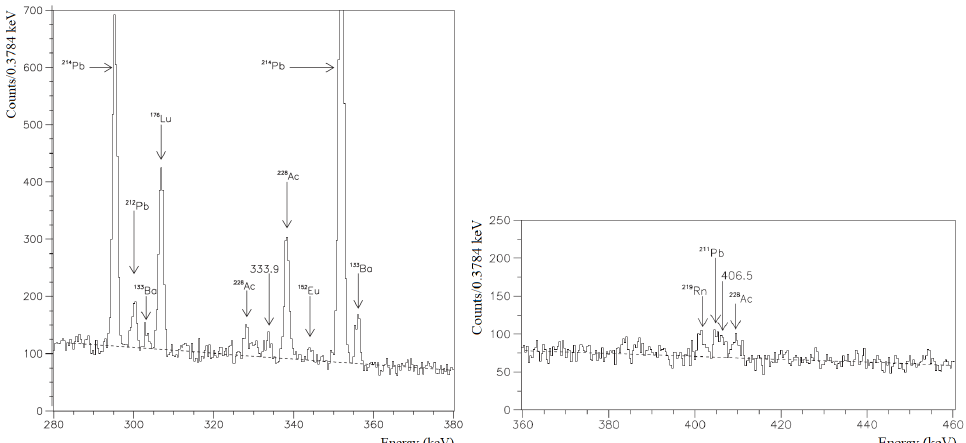
Figure 8. Energy spectrum collected in the HP-Ge experiment of Reference [17]. The two plots show the energy ranges of interest to search for the presence of the gamma’s related to the decay of the excited states of the daughter nucleus. Reprinted from Reference [37] with permission from American Physical Society.